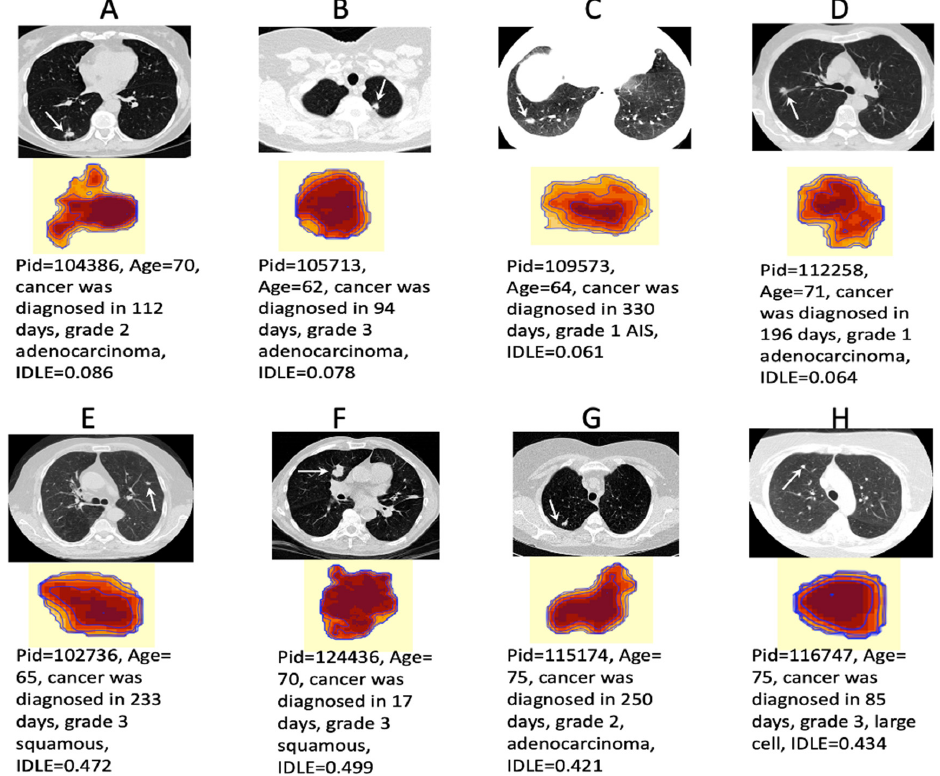
Figure 3. Examples of LDCT tumor texture maps and IDLE scores from four patients with nonaggressive tumors ( A – D ) who survived for over 10 years without cancer progression after the surgery and four patients with aggressive tumors ( E – H ) who died within 3 years after the surgery. Pid = patient ID number in the NLST.